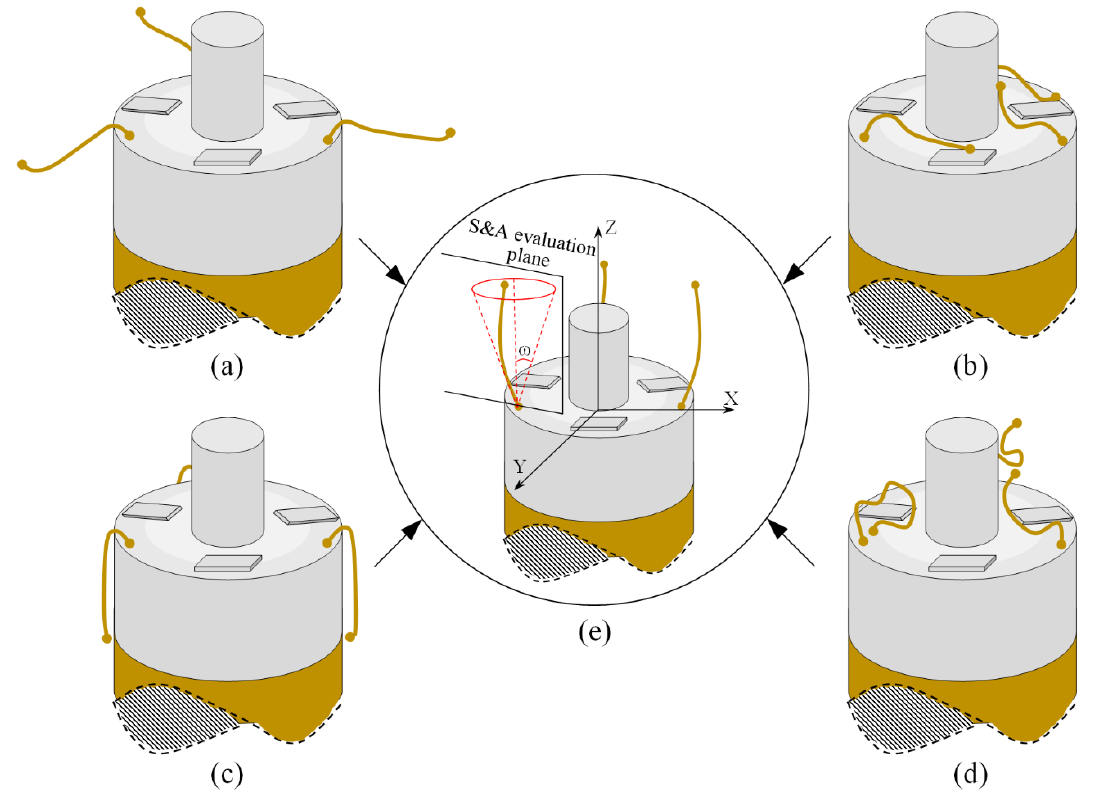
Figure 2. The S&A of electrode wires: ( a ) The attitude of the wires suspended on the outside of the coil. ( b ) The attitude of the wires attached or suspended on the pad surface. ( c ) The attitude of the wires attached to the periphery of the coil sidewall. ( d ) The shape of the wires with random curl. ( e ) The ideal brushing result of wire S&A.